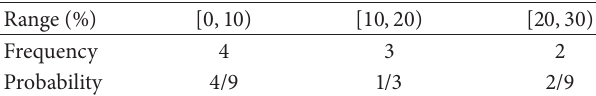
Table 4: The statistic table of annualized volatility of spot copper price in China from 2007 to 2015.